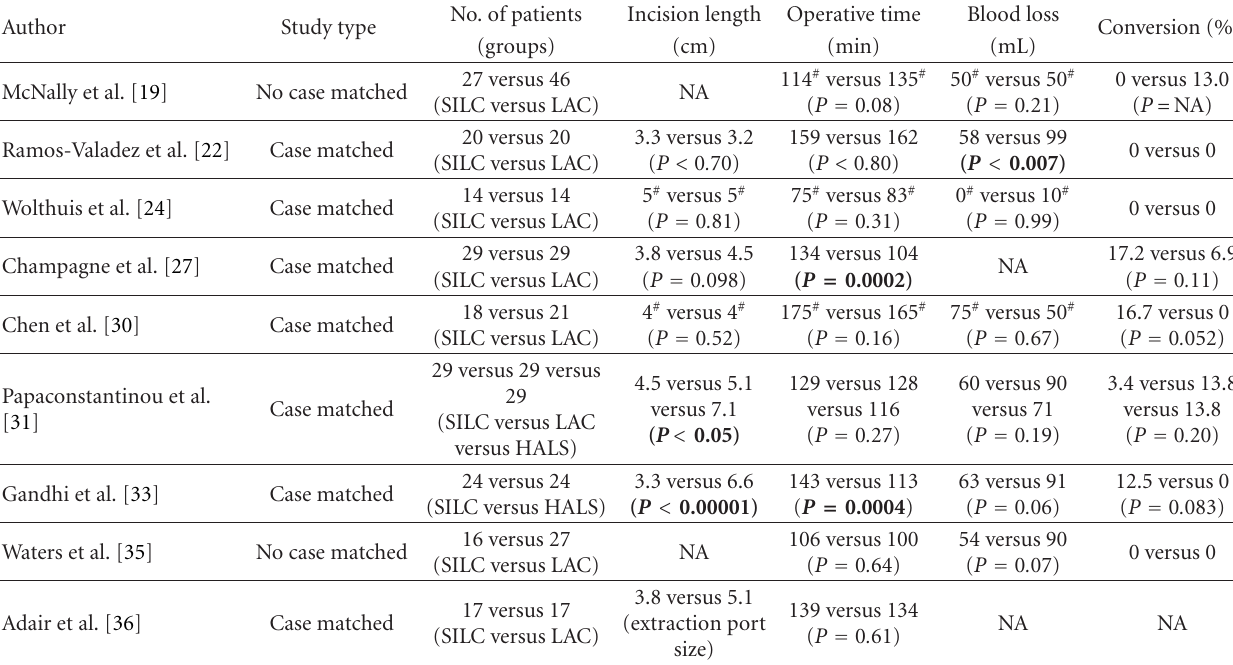
Table 5: Comparison of intraoperative parameters between single-incision laparoscopic colectomy and other minimally invasive